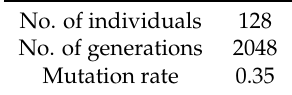
Table 6. Genetic algorithm evaluation